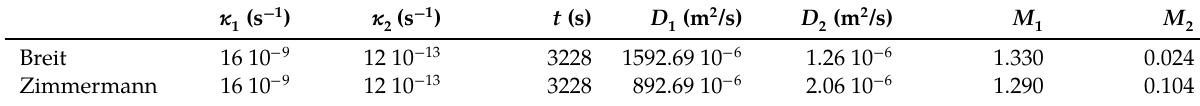
chloride concentrations of reinforced crit.